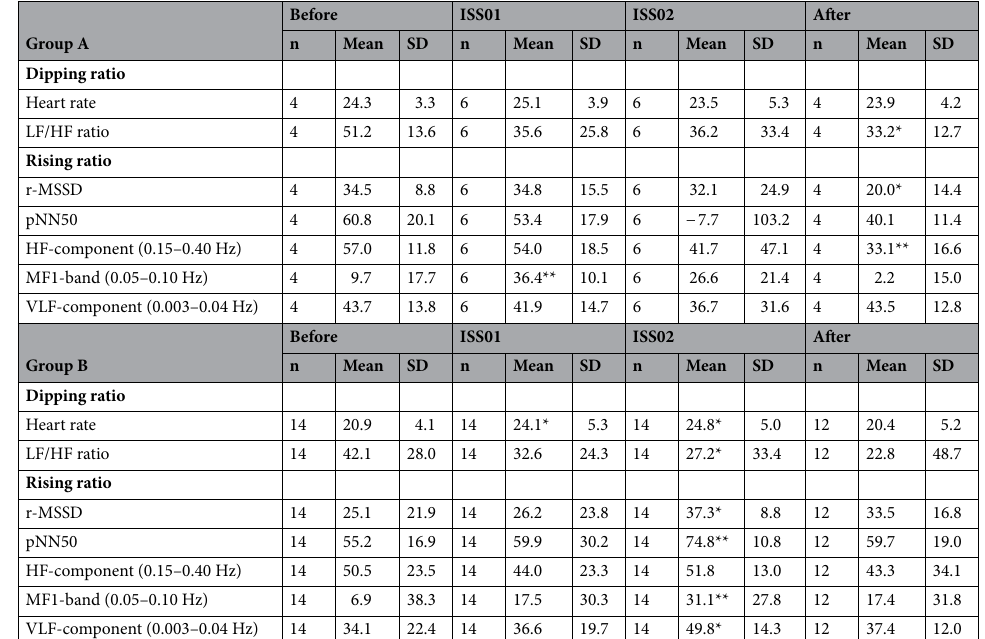
Table 3. Sleep-related changes in HR dip and HRV rise in space. Paired t-test * P < 0.05, ** P < 0.01 (versus Pre-launch); Ratios estimated during each night separately. P -values not corrected for multiple testing. In Group A, the data were insufficient to estimate the drop/rise ratio in 1 astronaut before launch and in another astronaut after return to Earth. Similarly in Group B, the data were insufficient to estimate the drop/rise ratio in 1 astronaut after return to Earth. Data analyzed on separate 24-h